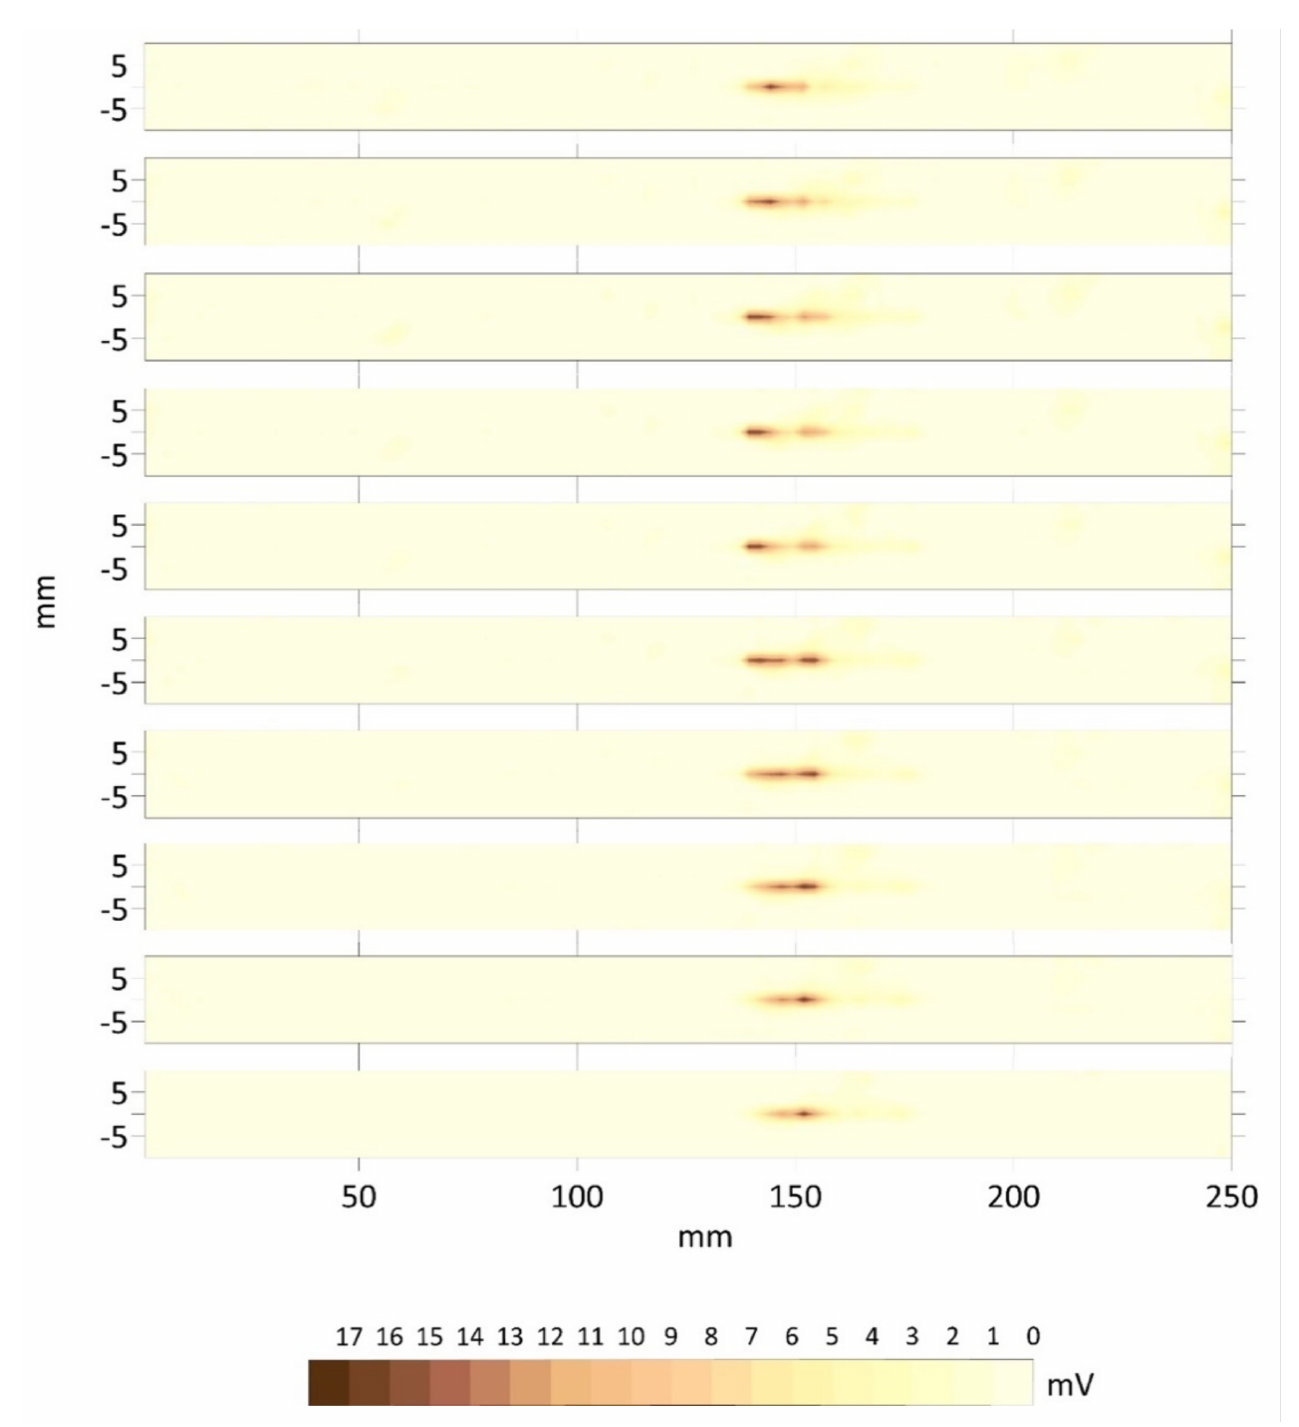
Figure 5. Horizontal top views of the F3–13 probe for the depths of 3.475 mm to 4.35 mm every 0.15